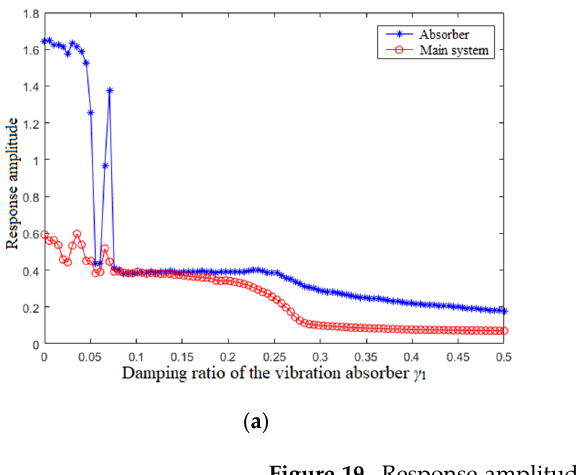
Figure 19. Response amplitude and phase diagram of two vibrators in the case of off-resonance ω = 1.6. ( a ) Response amplitude; ( b ) Phase diagram ( γ 1 = 0).